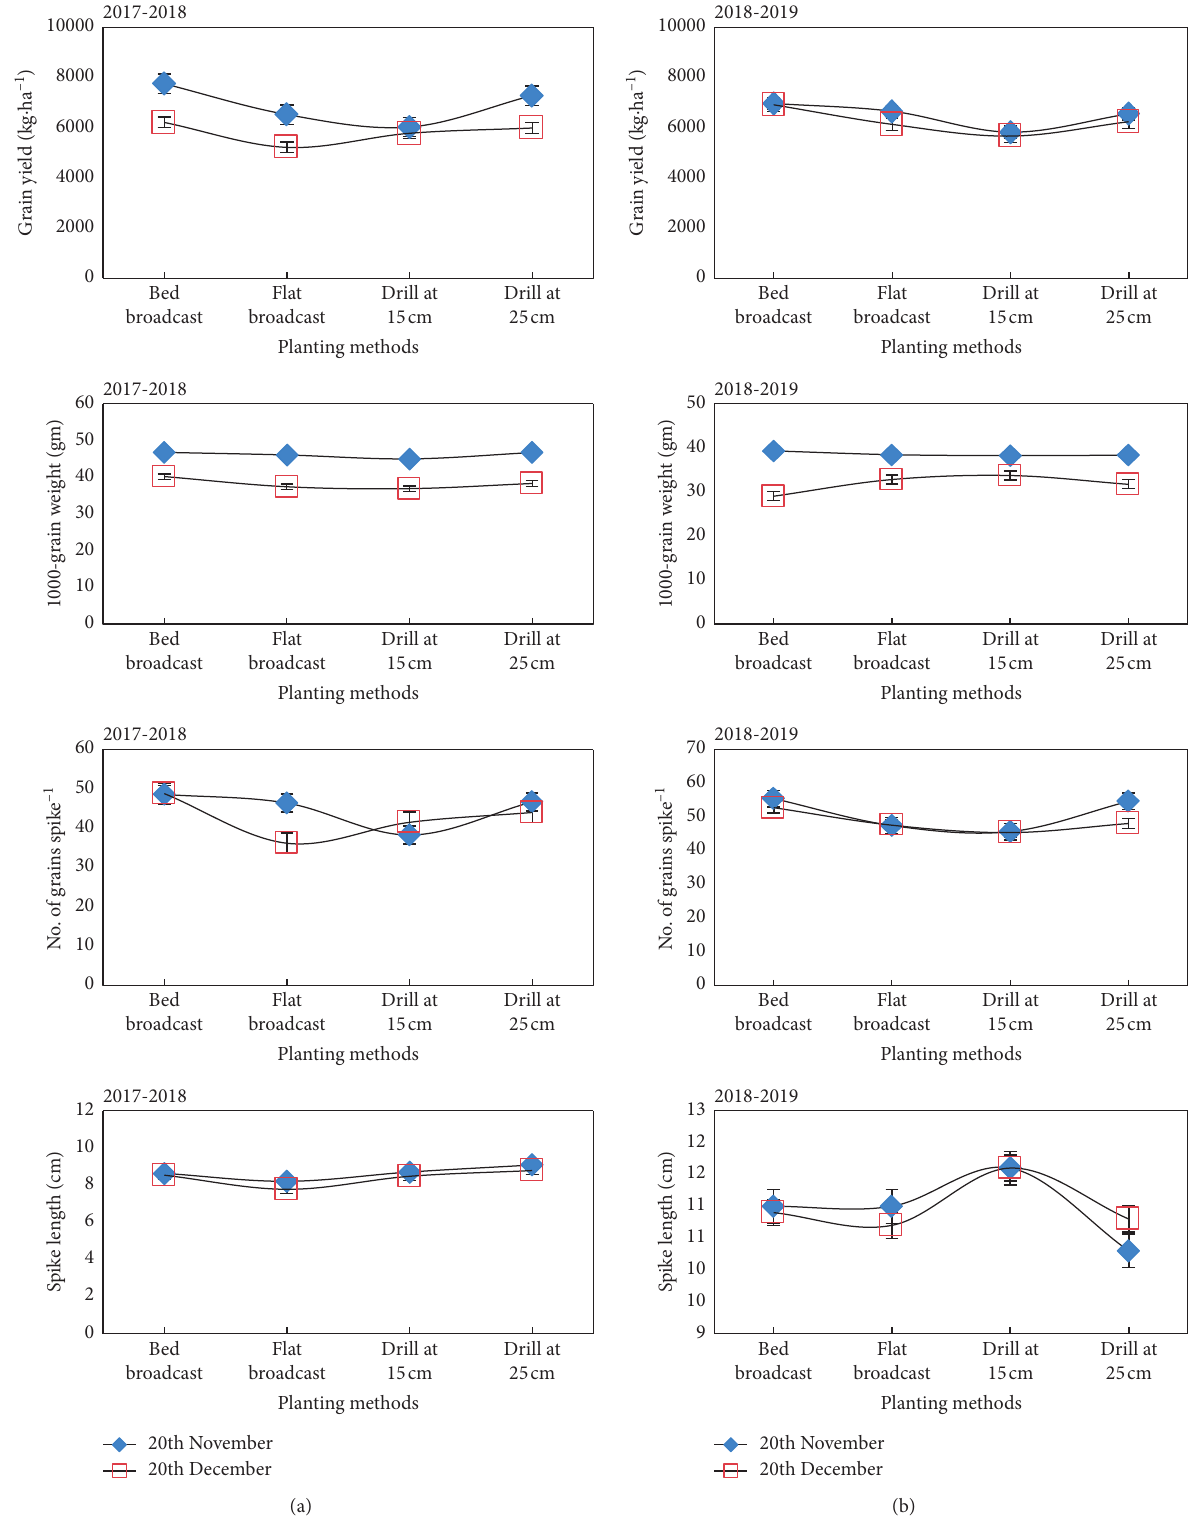
Figure 3: Wheat grain yield, 1000-grain weight, no. of grains per spike, and spike length as affected by planting dates and planting methods during 2017-2018 and 2018-2019